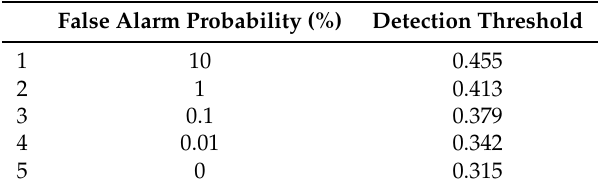
Figure 8. The ratio method curve for PRN 23. The solid curve is the ratio method metric. The dashed curves are detection thresholds according to different false alarm probabilities. Table 2. The relationship between false alarm probability and detection threshold for the ratio